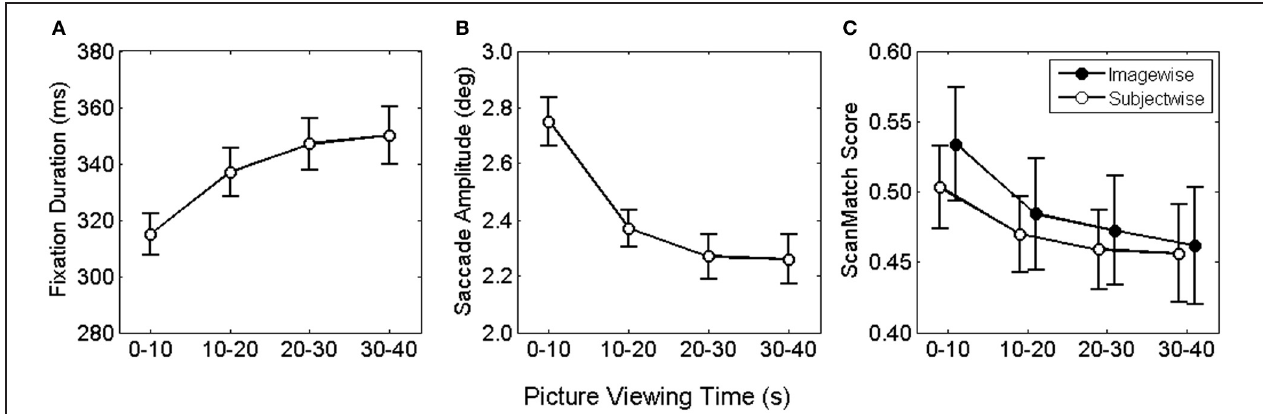
FIGURE 1 | Mean fixation duration (A) saccade amplitude (B) and viewing similarity (C) as function of viewing time. Error bars depict the mean standard